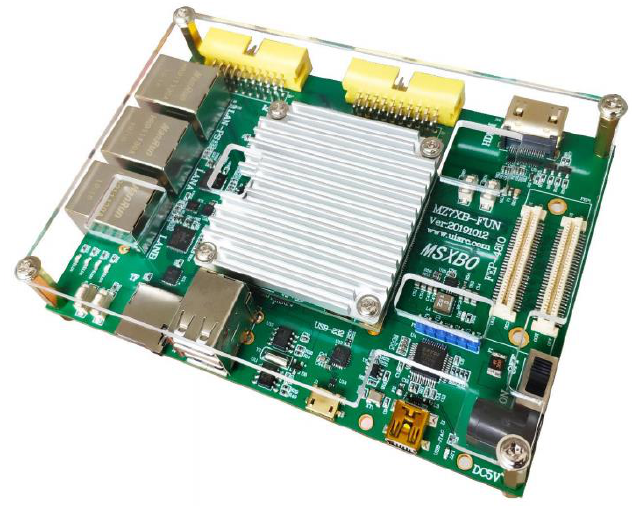
Figure 19. Typical application system of the FPGA accelerator for CNN-based malware traffic classification.